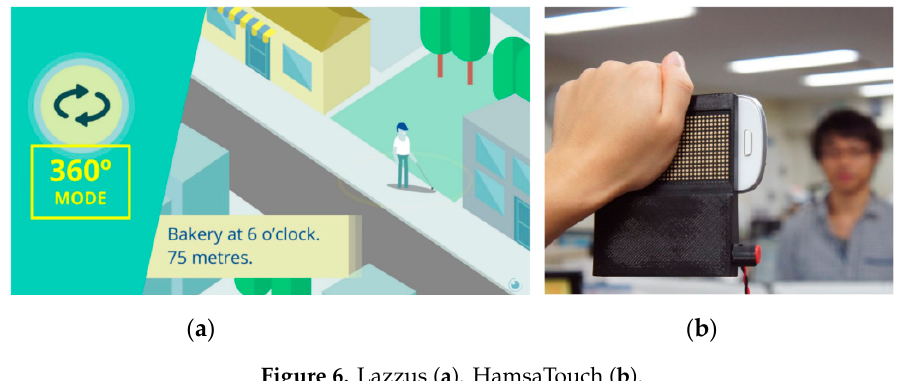
Figure 6. Lazzus ( a ). HamsaTouch ( b ).